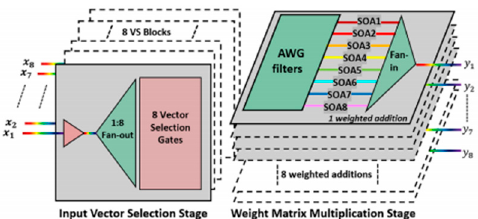
Figure 2. SOA wavelength division multiplexer [22]. The chip integrates 8 weighted addition circuits, which are used for 8 WDM input vectors and provide 8 WDM outputs. SOA is used to assist the weight sum of each layer. Highlight the block in use in gray.